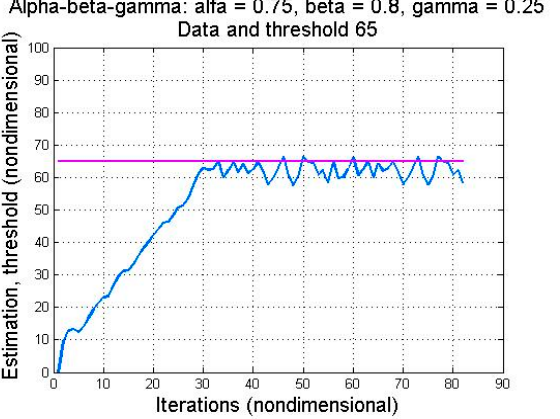
Figure 9. The estimated value of the α – β – γ filter exceeds the threshold at iteration 33.